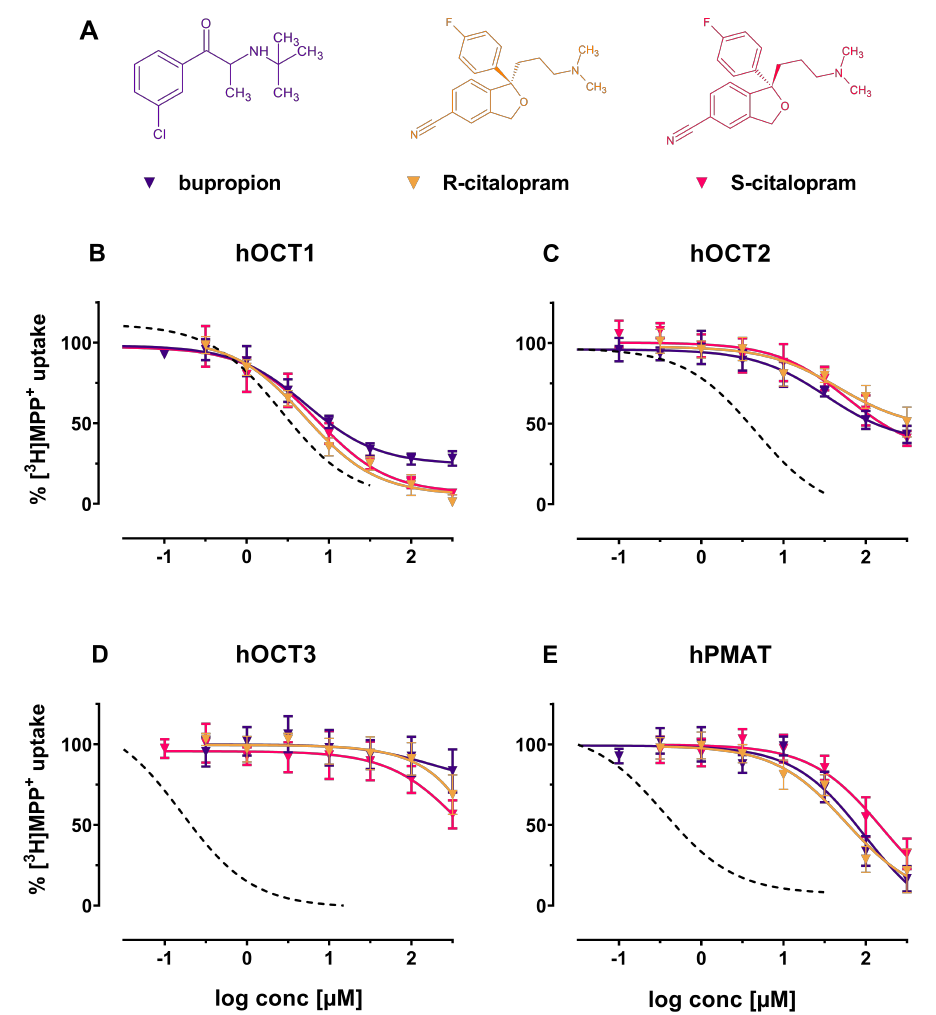
Figure 2. ( A ) Chemical structures of the herein investigated antidepressant compounds. From left to right: bupropion (violet), R-citalopram (yellow) and S-citalopram (red); Effects of the above-mentioned compounds (including decynium-22; dashed line) on ( B ) hOCT1, ( C ) hOCT2, ( D ) hOCT3 and ( E ) hPMAT of uptake of tritiated MPP + in HEK293 cells stably expressing the respective